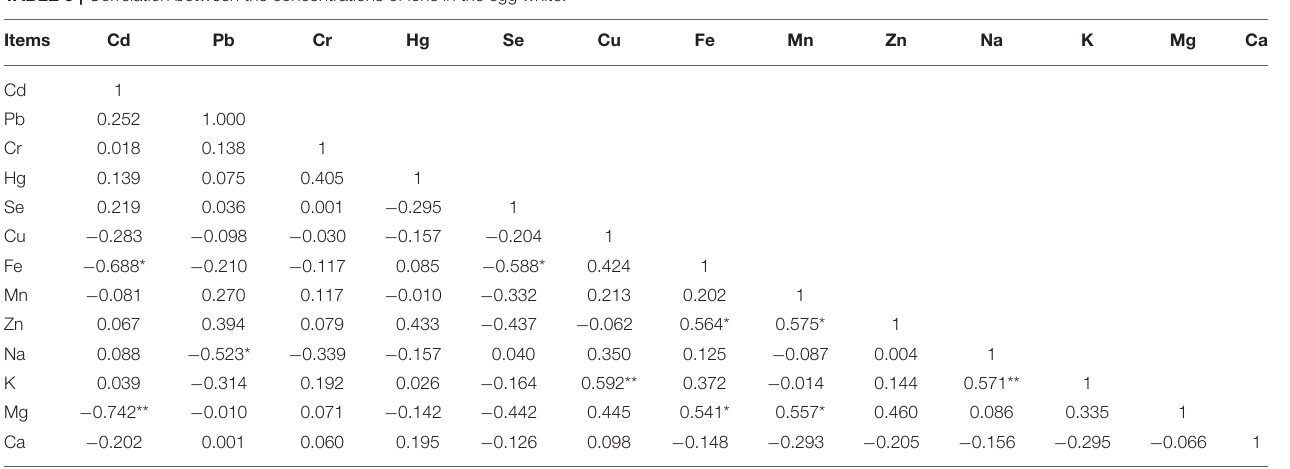
TABLE 3 | Correlation between the concentrations of ions in the egg